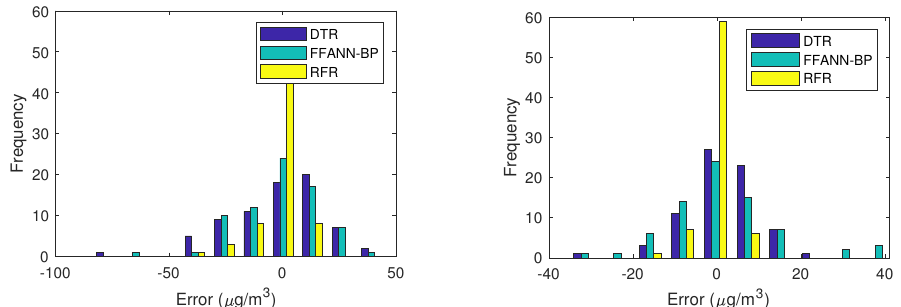
Figure 12. The error histogram of the prediction for PM 2.5 and PM 10 at Ma Lian Kou.